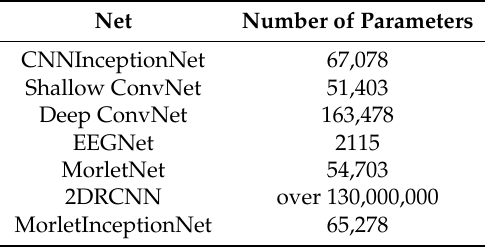
Table 1. Numbers of parameters in various